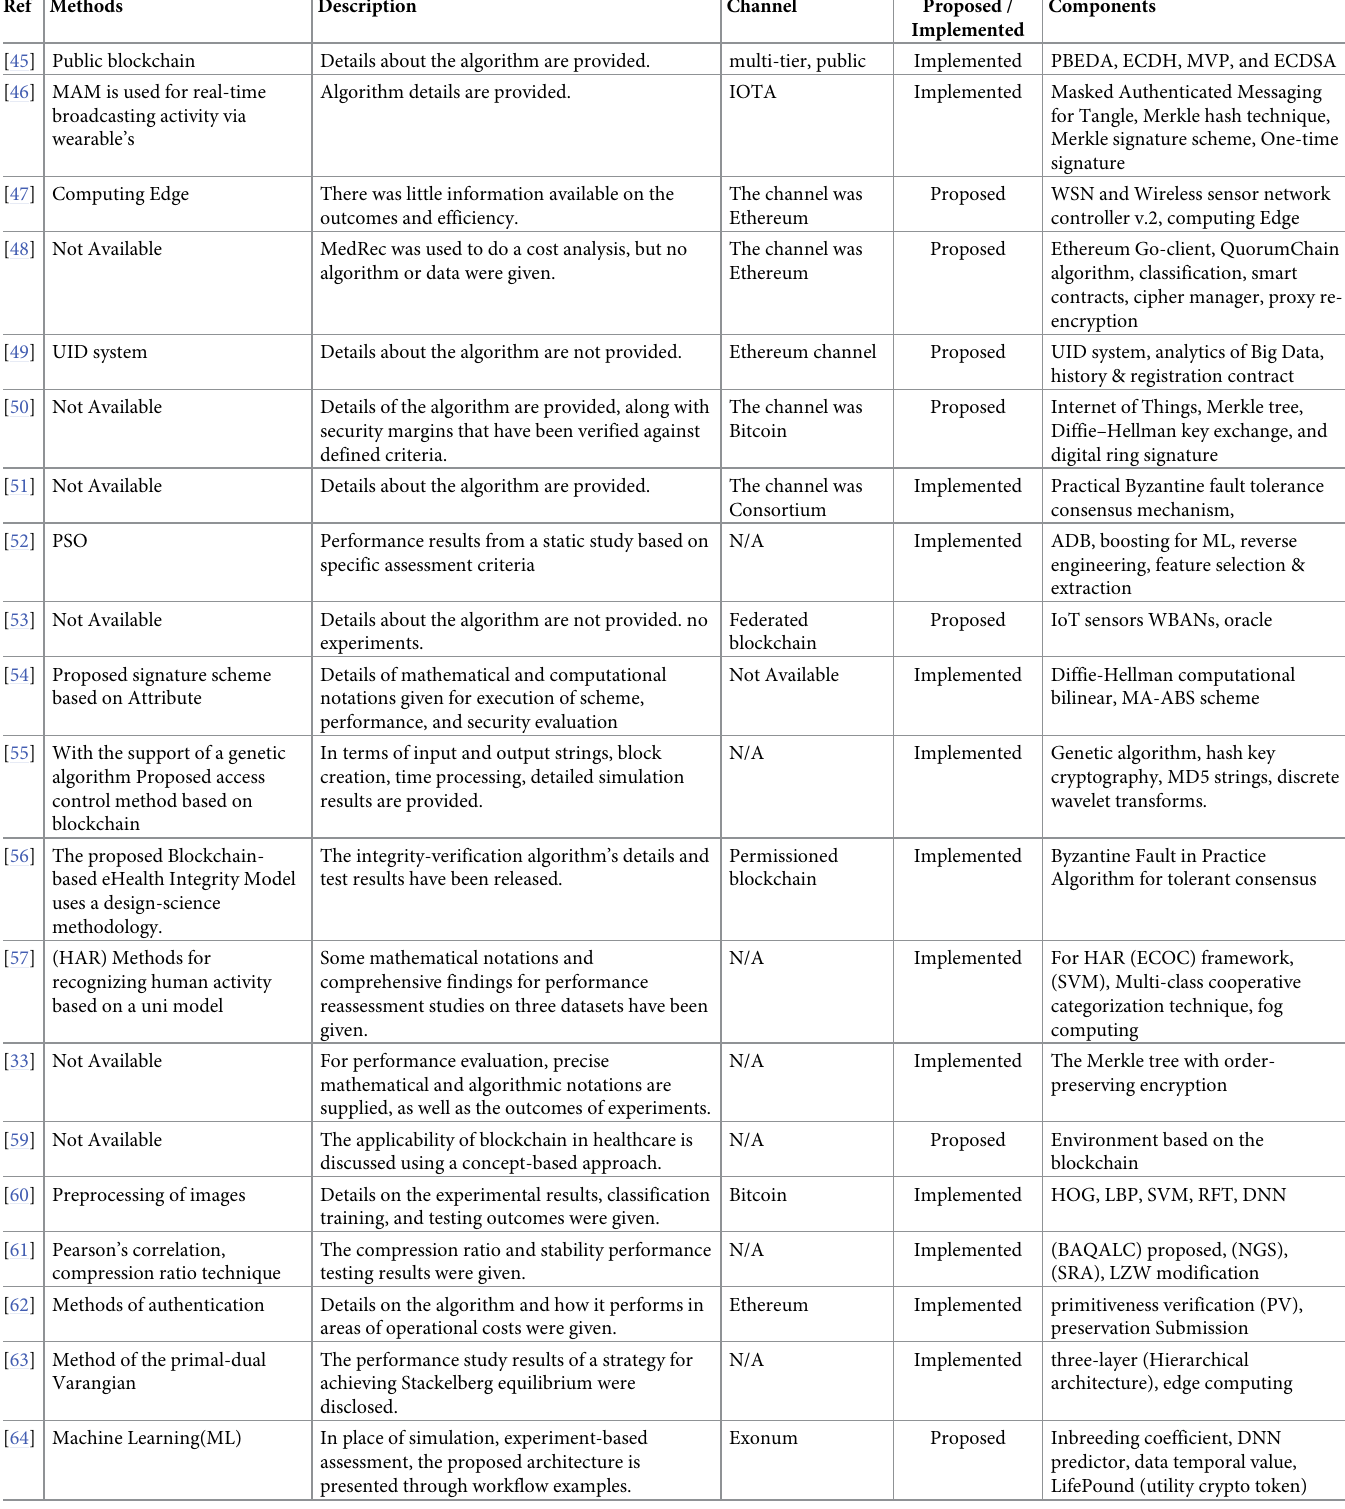
Table 3. Comprehensive description of reviewed studies.